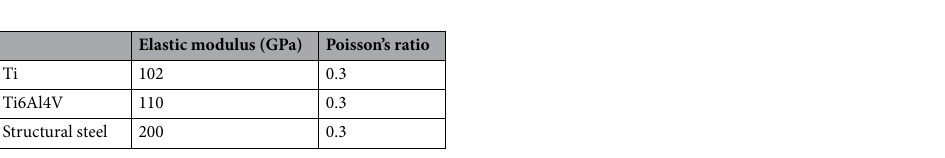
Table 1. Materials characteristics.